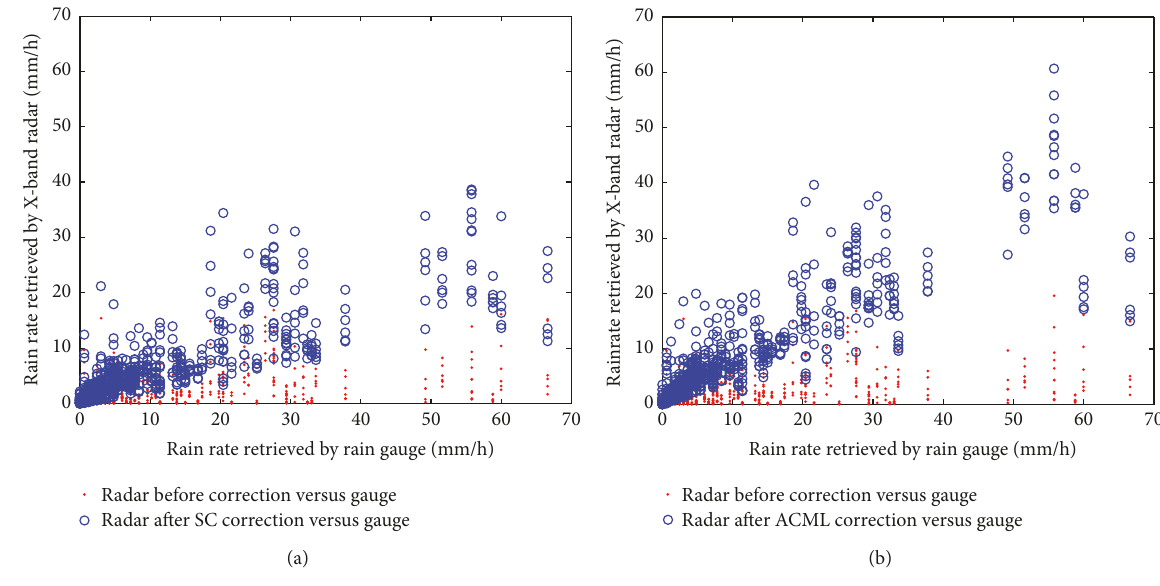
Figure 18: Scatter plot of (a) rainfall retrieved by the XR before correction and after SC correction against the rainfall retrieved by gauges 7 to 12 and (b) rainfall retrieved by the XR before correction and after ACML correction against the rainfall retrieved by gauges 7 to 12 during 0000 to 0500 UTC, 1 June 2016.